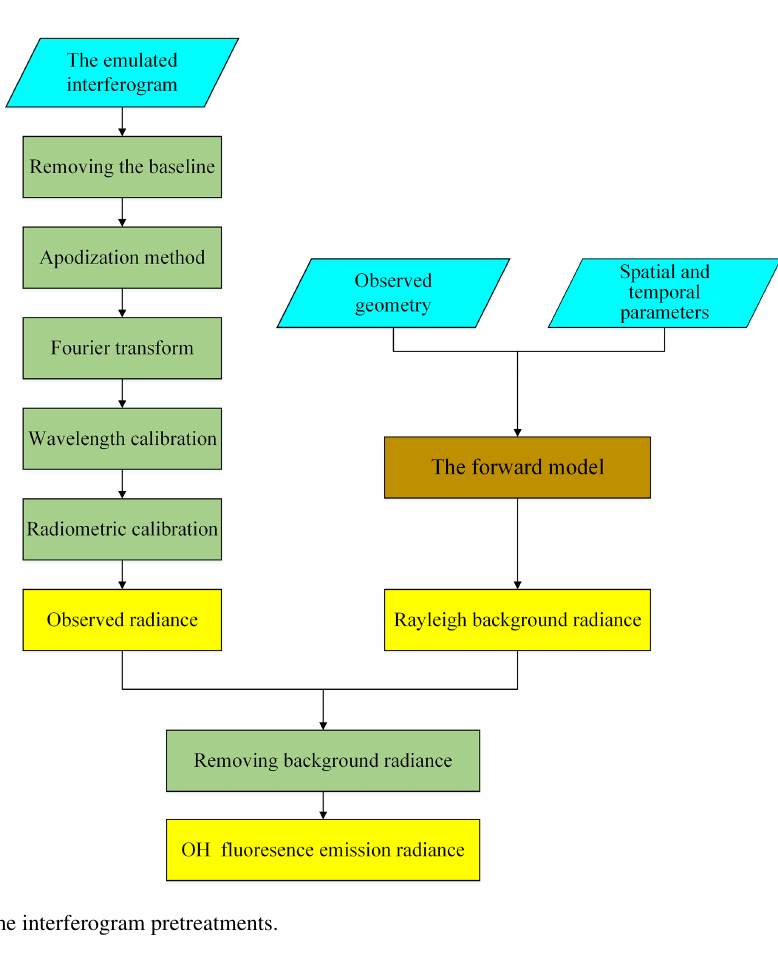
Figure 12. Flowchart of the interferogram pretreatments.